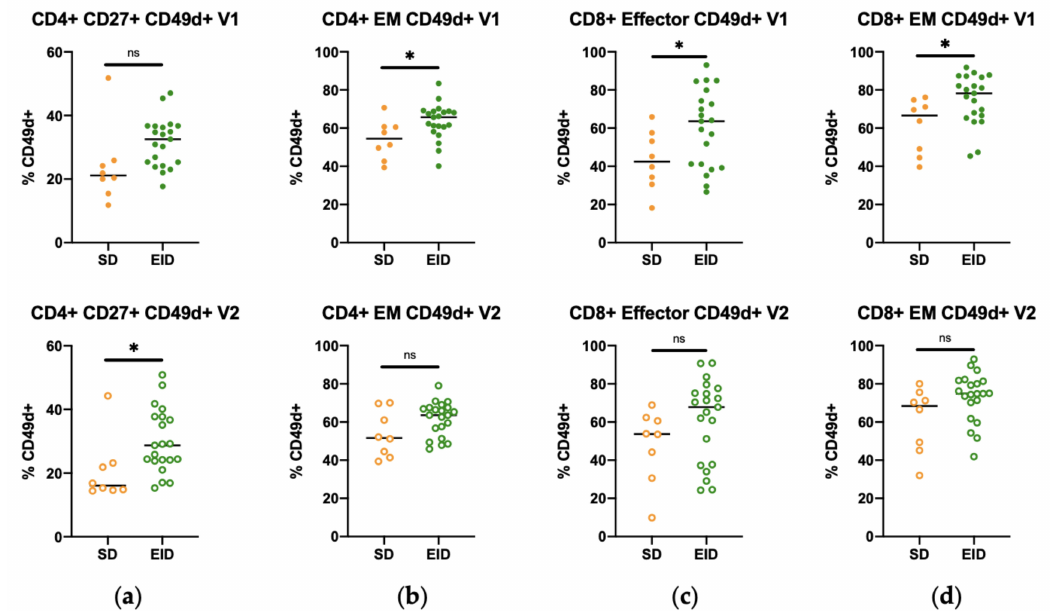
Figure A4. Representation of SD and EID groups in some CD4 + and CD8 + T lymphocytes subpopulations in RRMS patients under Natalizumab treatment in both first (V1) and second (V2) extractions. Percentage of expression of CD49d in ( a ) CD4 + CD27 + , ( b ) CD4 + Effector Memory (EM), ( c ) CD8 + Effector and ( d ) CD8 + Effector Memory (EM) T lymphocytes Each dot represents the percentage of expression for each marker regarding their parent population (CD4 + or CD8 + T lymphocytes populations) in the SD ( n = 8) or EID ( n = 21) groups. EID, extended interval dosing; EM, effector memory; SD, standard dosing. ns: p > 0.05, * p <